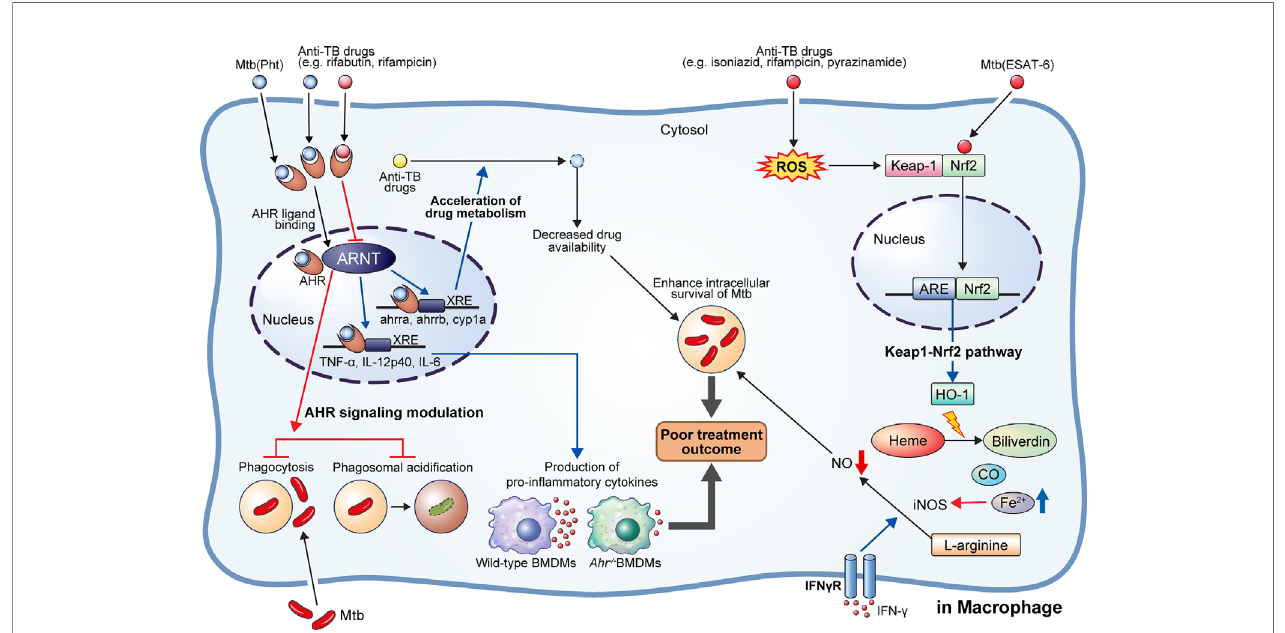
FIGURE 2 | AhR modulation by anti-TB drugs and downstream events. NRF2-KEAP1 signaling and AhR signaling pathways generally protect cells by detecting and preventing damage to endogenous and exogenous substances such as oxidative stress and toxins. They can also detect M. tuberculosis (Mtb) infection or anti-TB drugs and affect host defense and drug metabolism. 1,4-naphthoquinone phthiochol (Pht) produced by Mtb and anti-TB drugs can attach to AhR present in the cytoplasm across the cell membrane. The combined ligand and receptor complex transfers into the nucleus and heterodimerizes with AhR nuclear translocator (ARNT). The ligand, receptor, and ARNT complex binds to xenobiotic response elements (XRE) that are speci fi c DNA sequences found in the target gene promoter region. Activation of the AhR by Pht and anti-TB drugs (e.g., rifabutin, bedaquiline) in macrophages induces impaired phagocytosis of Mtb H37Rv, and phagosome acidi fi cation, and production of pro-in fl ammatory cytokines. Furthermore, activation of AhR facilitates the hepatic metabolism of drugs, ultimately reducing drug availability. Meanwhile, some drugs (e.g., rifampicin) act as AhR inhibitors, inducing impairment of phagocytosis and phagosome acidi fi cation, consequently improving the intracellular survival of Mtb in macrophage and zebra fi sh models. On the other hand, Mtb ESAT-6 and anti-tuberculosis drugs (e.g., isoniazid, rifampicin, pyrazinamide) act on Nrf2-Keap1 signaling to induce the translocation of Nrf2 to the nucleus by degradation of Keap-1. The translocated Nrf2 binds to the antioxidant response element (ARE) and upregulates antioxidant enzymes. Production of hemeoxygenase-1 (HO-1), a representative antioxidant enzyme, is activated, which subsequently induces catabolism of heme to biliverdin, CO, and Fe 2+ . Elevated Fe 2+ inhibits the production of nitric oxide from L-arginine mediated by IFN- g signaling. Thus, activation of heme catabolism by HO-1 induces the reduction of intracellular bacterial killing. Taken together, activation of AhR signaling and HO-1 production induces a pathogen-bene fi cial effect that enables persistent